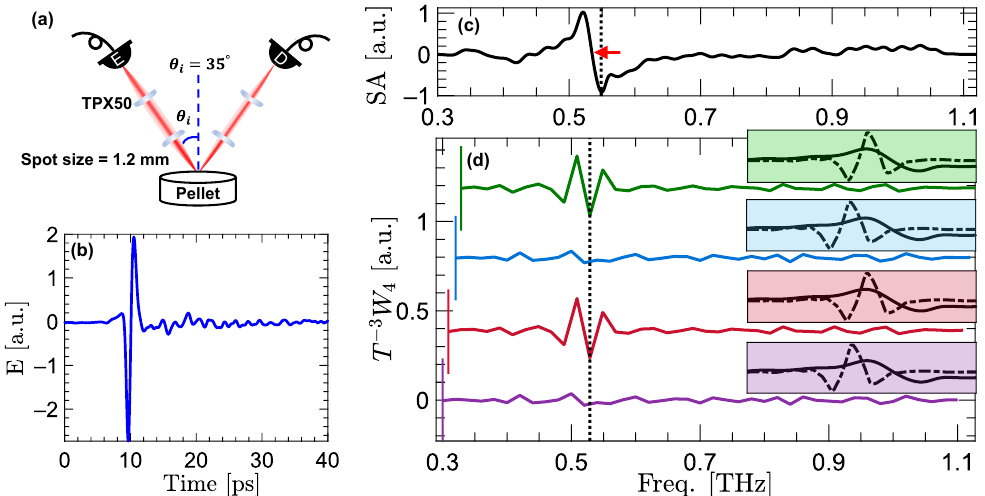
Figure 2. ( a ) The schematic of the measurement setup. The specular reflections are measured at θ i = θ r = 35 ◦ . ( b ) An example THz pulse reflected from an α -lactose pellet. ( c ) The spectral amplitude (SA) of α -lactose over the frequency range of f = 0.3–1.13 THz. A red arrow marks the zero-crossing at 0.53 THz, which is a characteristic resonance mode of α -lactose. ( d ) The vertically-offset fourth-level DWT wavelet coefficients of SA, applied in the frequency domain. Each line in ( d ) is composed of the wavelet coefficients calculated from a different spectral range, i.e., f = 0.30–1.10 THz in the purple trace, f = 0.31 − 1.11 THz in the red trace, f = 0.32–1.12 THz in the blue trace, and f = 0.33–1.13 THz in the green trace. The lower bound of the frequency ranges are emphasized using vertical lines at the beginning of each trace. Each inset box shaded with the same color shows the overlap between the wavelet filter and the resonant signature at 0.53 THz in the corresponding reflection spectra. In each case, it can be noted that whether the resonance at 0.53 THz is resolved in T − 3 W 4 depends on the overlap between the spectral feature and the DWT wavelet